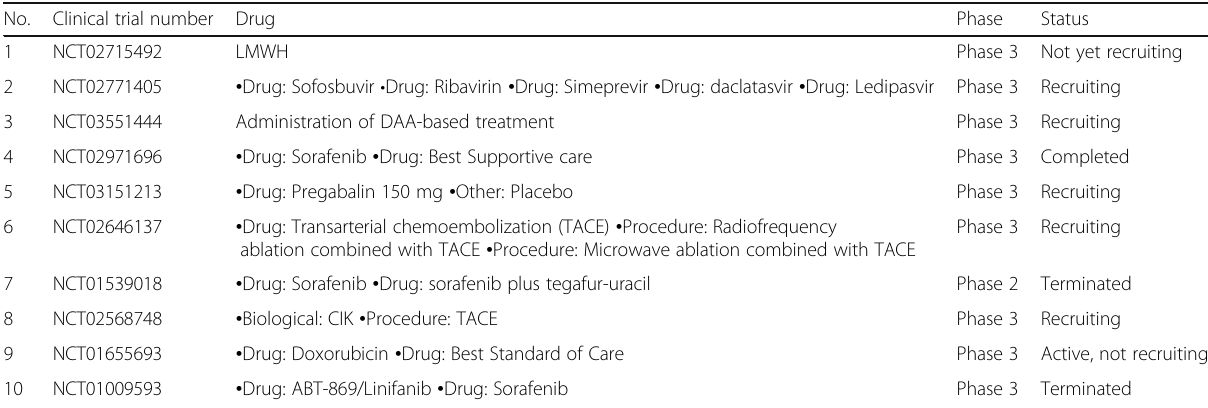
Table 3 HCC clinical Trials in Egypt No. Clinical trial number